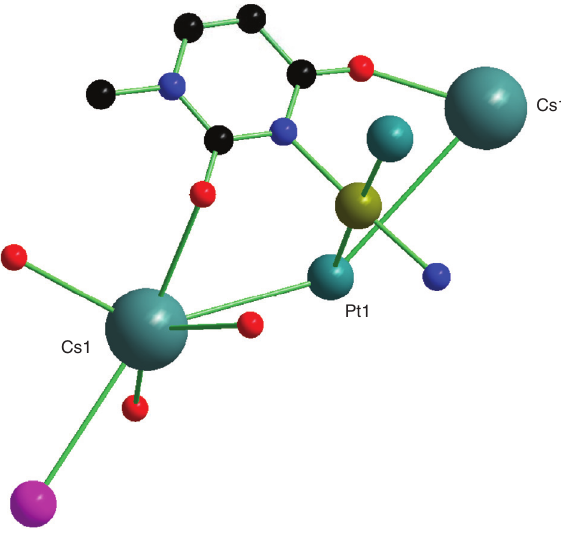
Figure 11 Simplified view of the molecular structure (diamond)